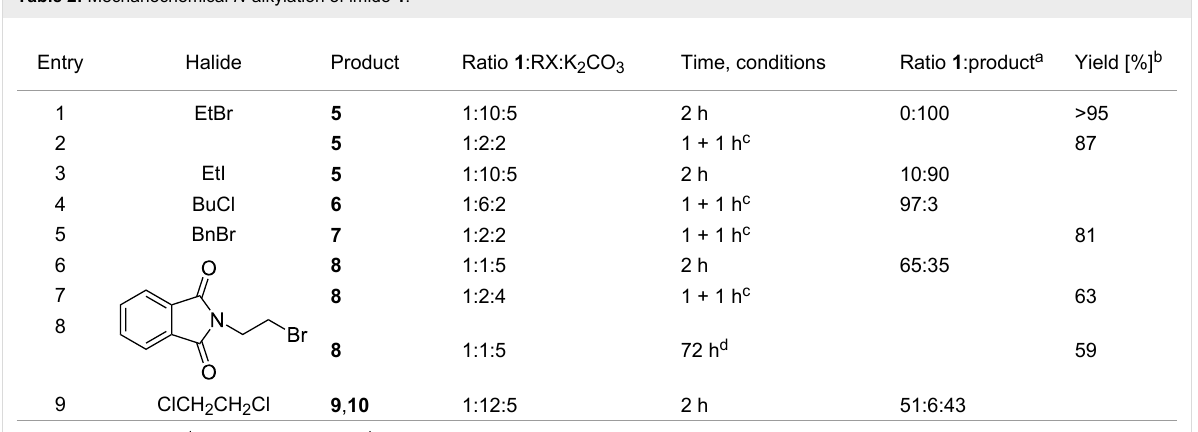
Table 2: Mechanochemical N -alkylation of imide 1